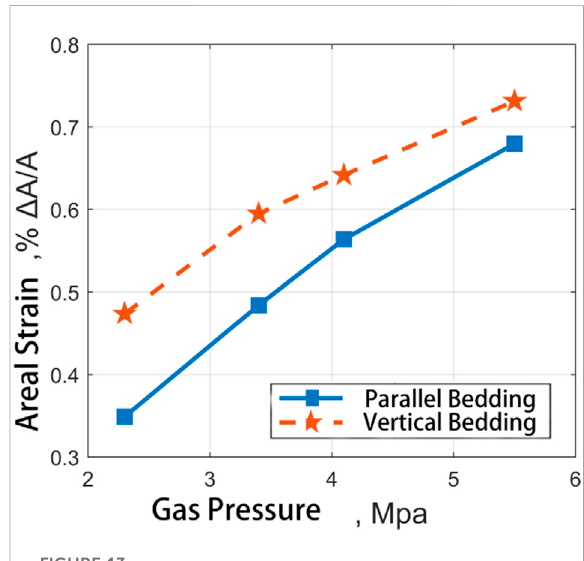
FIGURE 13 Comparativediagramofadsorptionstrainresultsoftwokinds of coal samples in the direction of straight bedding and parallel direction of bedding with the change of input pressure of CO 2 .